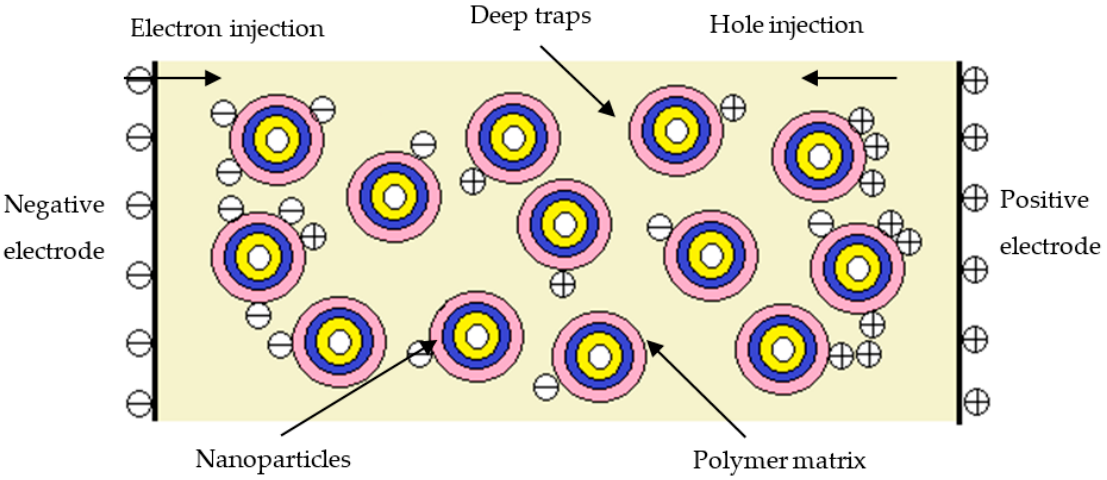
Figure 8. Transport model of carrier in the nanocomposites.